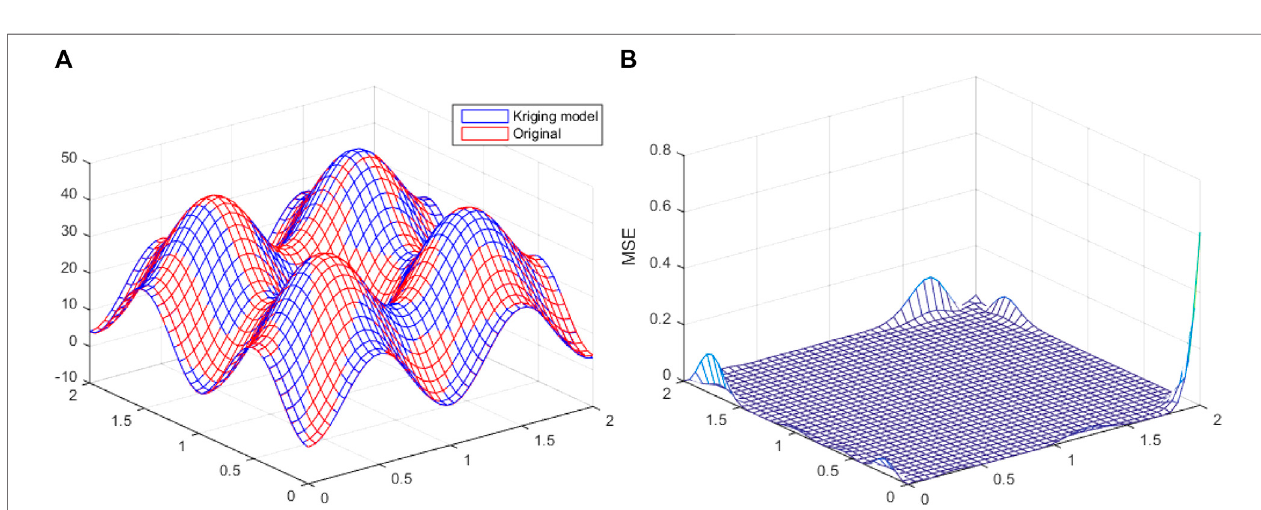
FIGURE 11 | Kriging model. (A) Comparison between the Kriging model and the real function. (B) Mean square error (MSE).